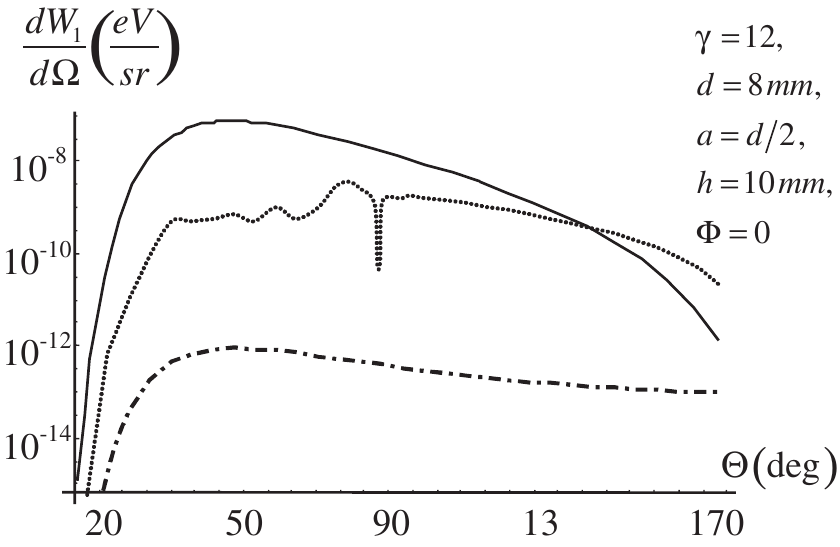
FIG. 7. Angular distribution of the SPR intensity for the lamellar grating: according to the current model—a solid line ( b=d (cid:5) 1 = 8 ); according to van den Berg’s model—a dotted line ( b=d (cid:5) 1 = 8 ) and a dash-dotted line ( b=d (cid:5) 0 : 001 ).